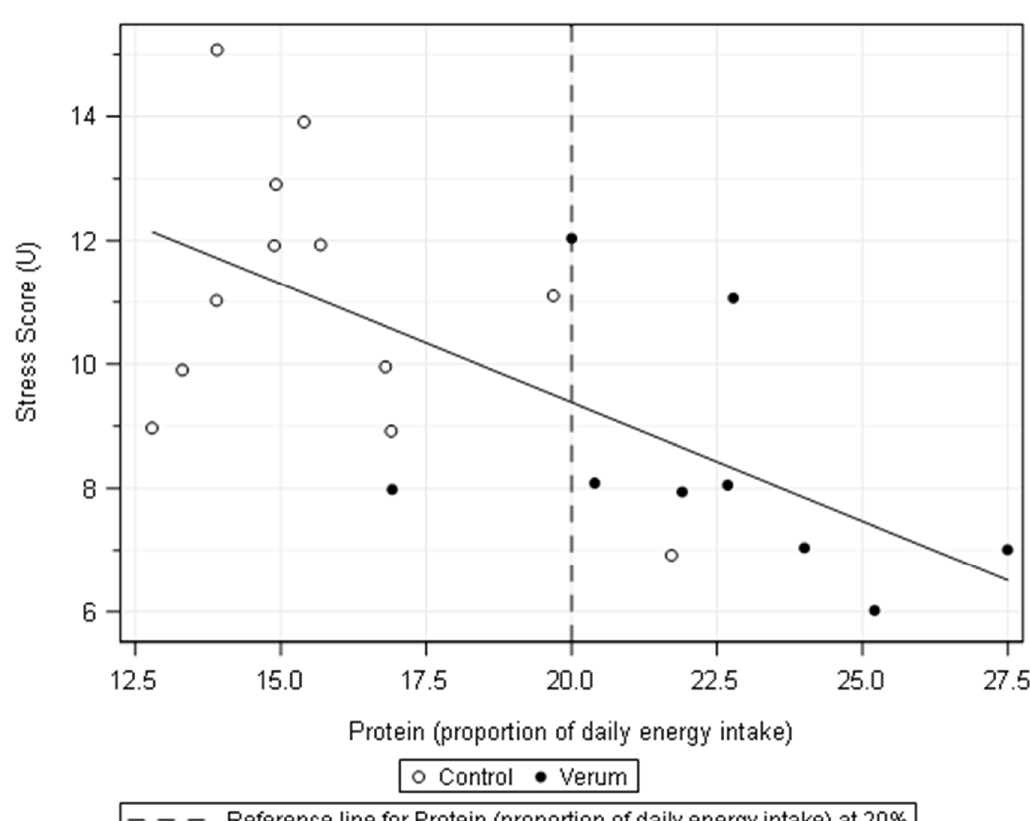
Figure 2. Scatterplot showing a linear regression line for the negative association between the calculated stress score and protein intake (proportion of daily energy intake) . Table 4. Differences in exercise-induced stress markers and the calculated stress score among the athletes who completed the marathon race ( n = 21) differentiated by their protein.